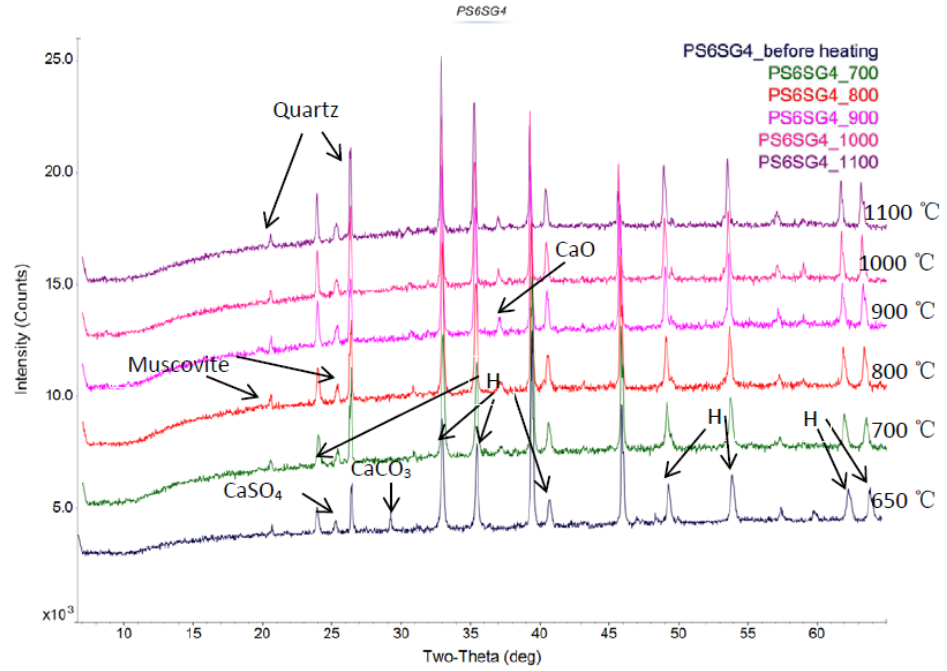
Figure 6. High temperature X ‐ ray diffraction (HT ‐ XRD) of SG4 fraction showing decomposition of CaCO 3 to CaO.